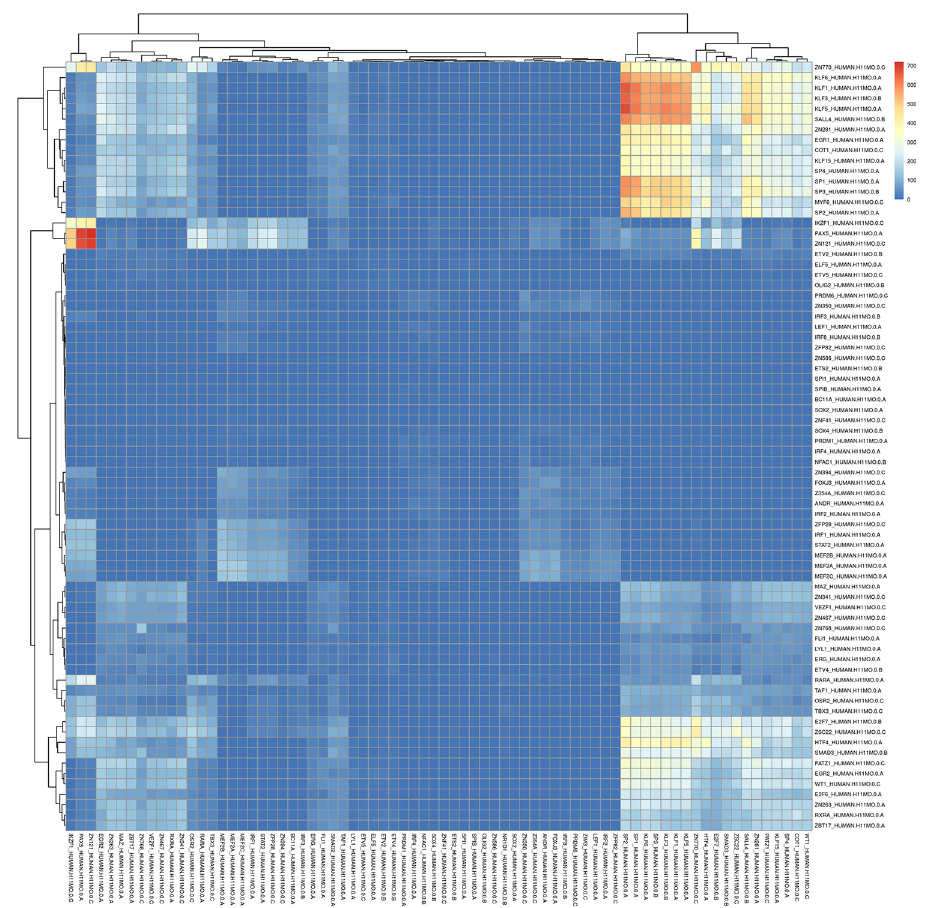
Fig 7. The co-enrichment of transcription factors on identified chromatin loops in H1-ESC with CTCF ChIA-PET training model.